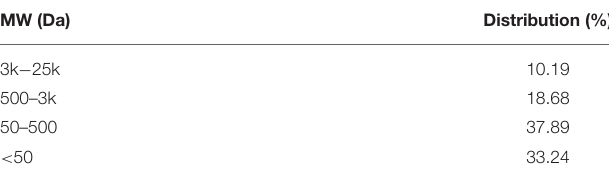
TABLE 1 | Molecular distribution of